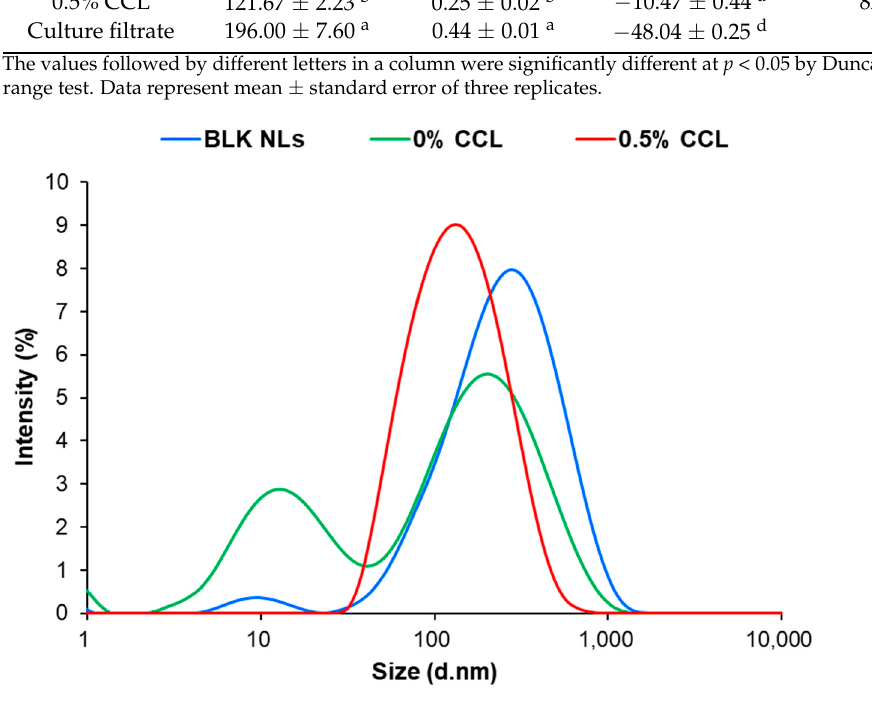
Figure 3. Size distributions (average diameter) of CS-coated CLP-loaded liposome (CCL). BLK NLs, blank liposome. Table 1. Average diameter, polydispersity index, zeta potential, and encapsulation efficiency of chi- tosan (CS)—coated cyclic lipopeptide (CLP)—loaded liposome (CCL) on 0.5% lecithin phospho- lipid.